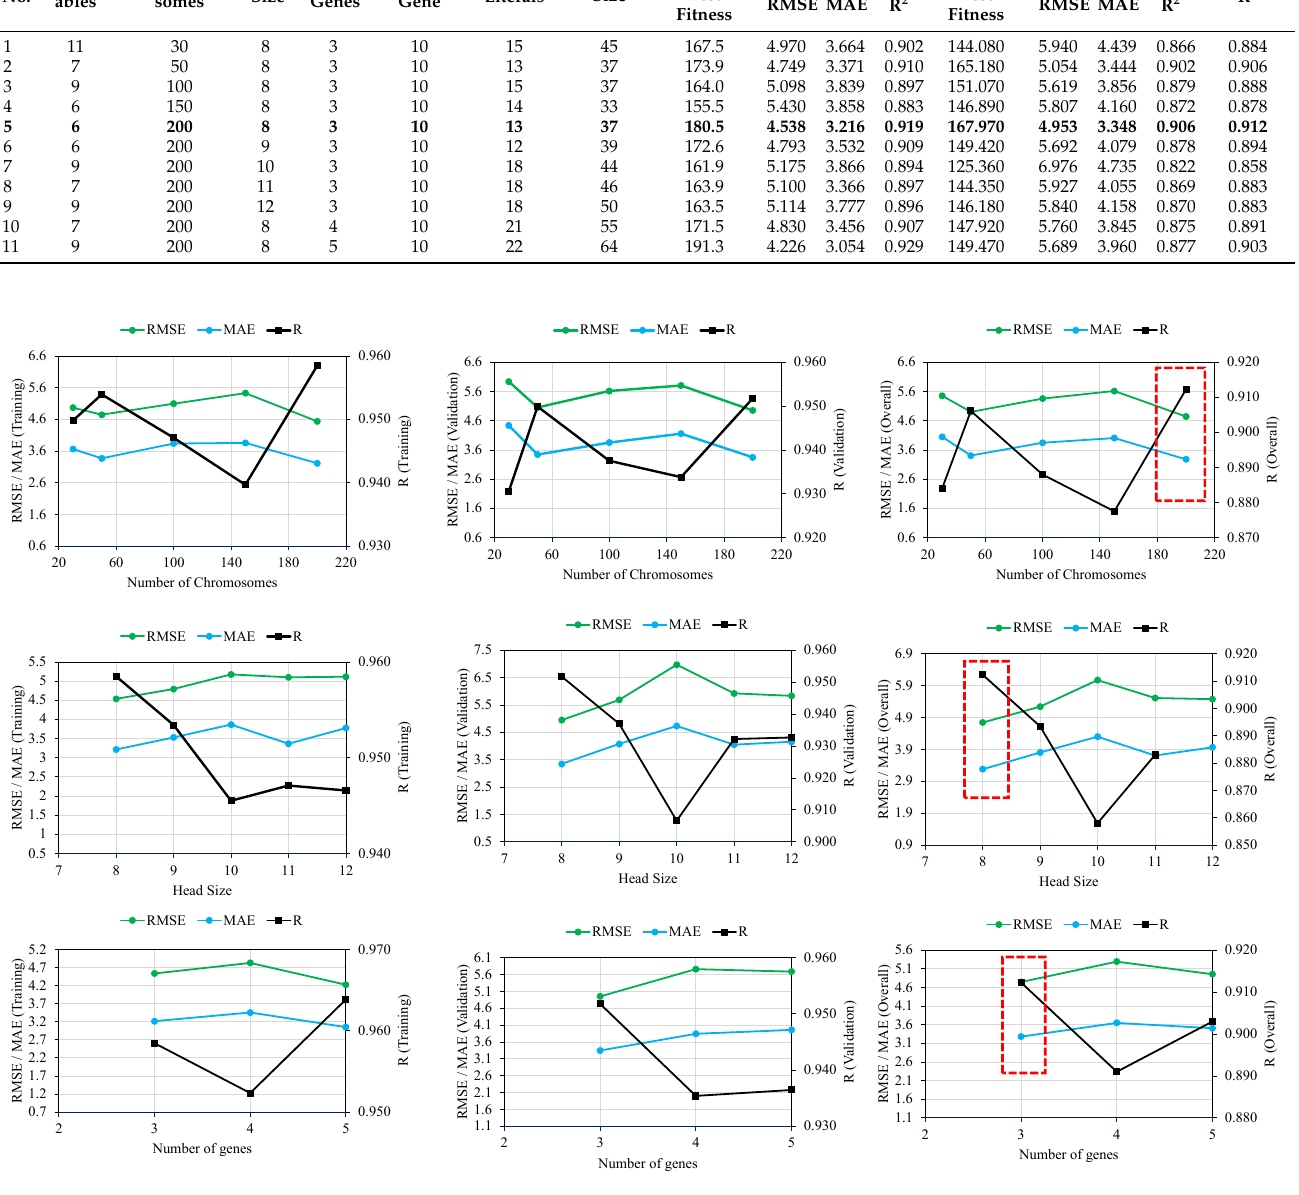
Figure 3. Effect of genetic variables on the performance of GEP models.